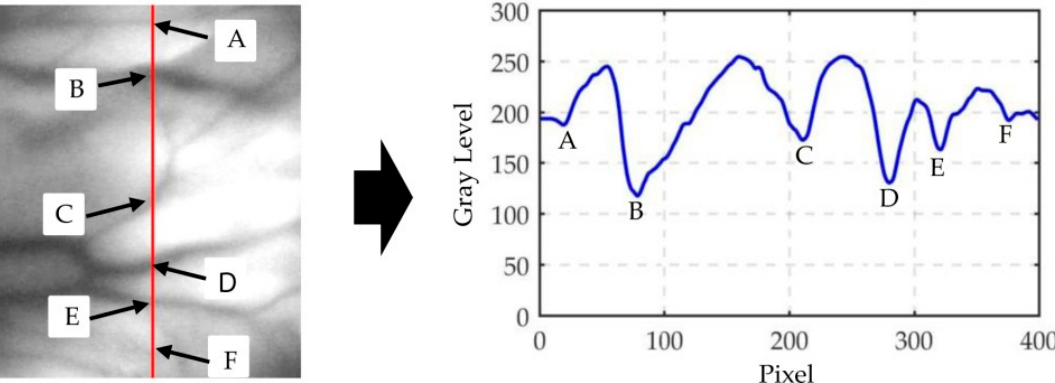
Figure 10. Vein location pixels A, B, C, D, E and F ( left ) from the vertical intensity profiles ( right